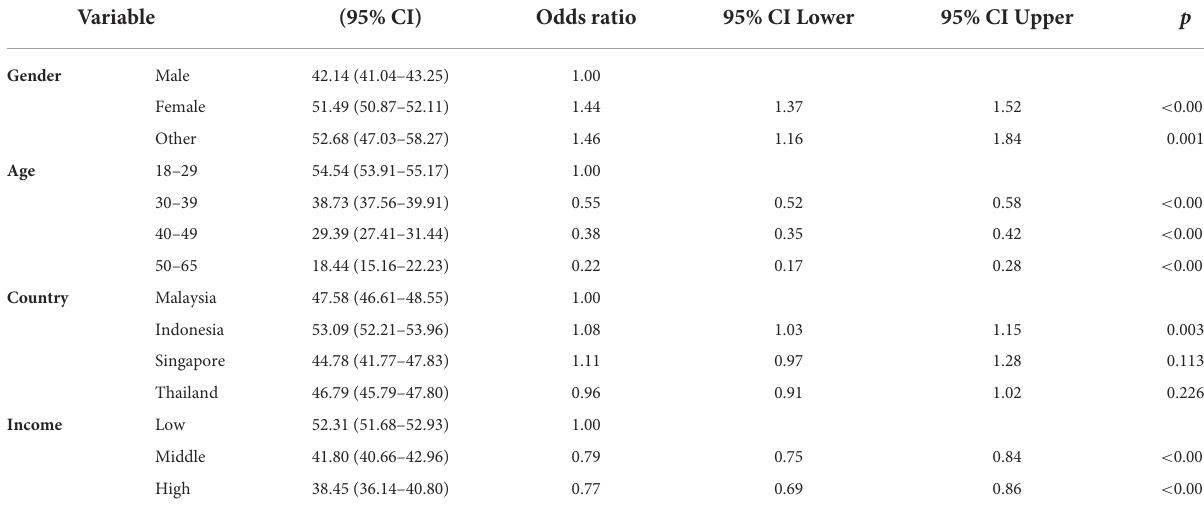
TABLE 3 Factors associated with severe/extremely severe anxiety symptoms.